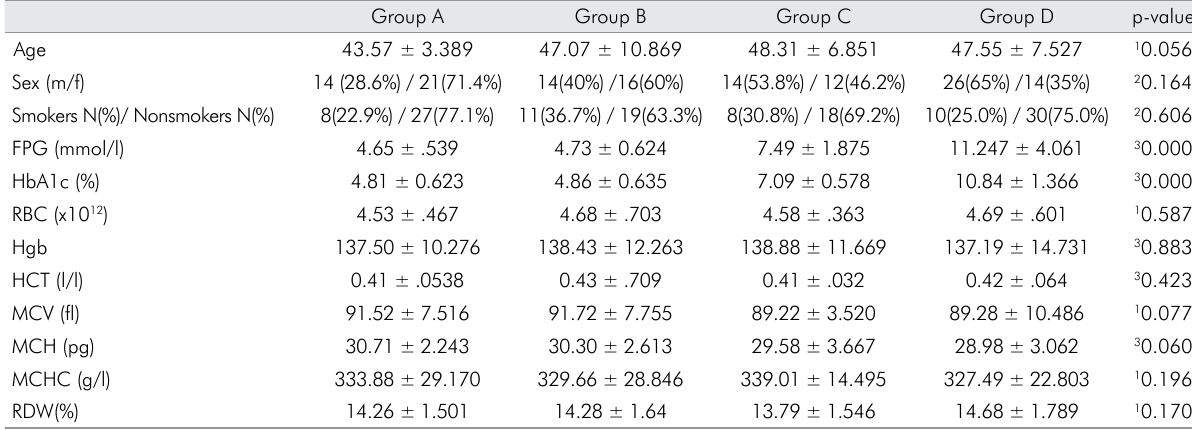
Table 1. Demographic and biochemical data of